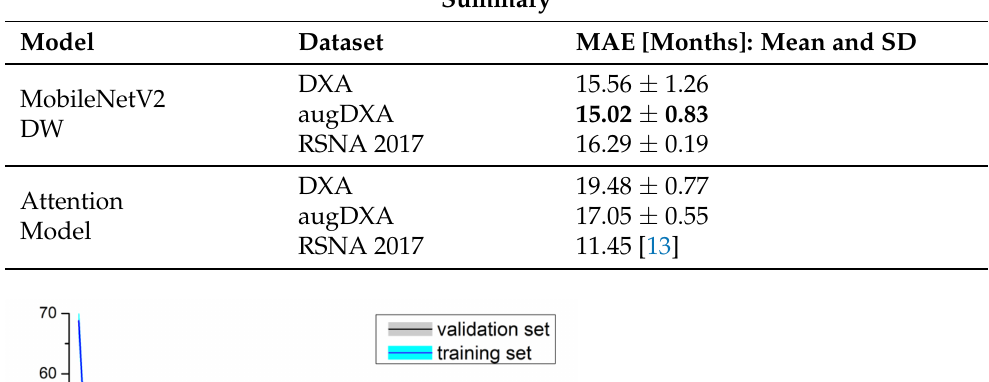
Table 4. Mean values and standard deviations of MAE obtained in Experiments I, II, and III.